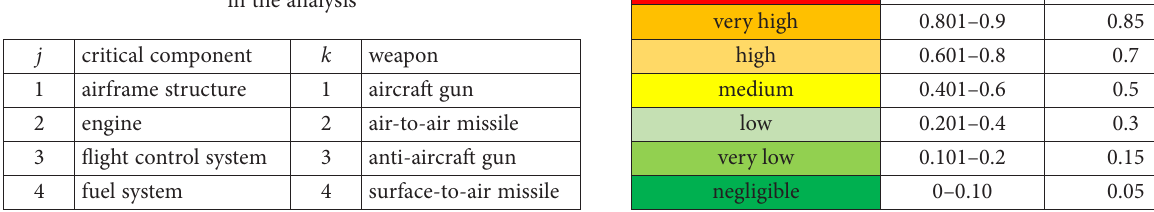
Table 2. Critical components and weapons included